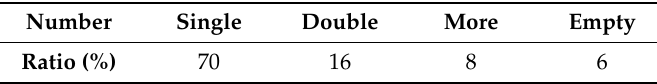
Table 3. The ratio of cells’ number in